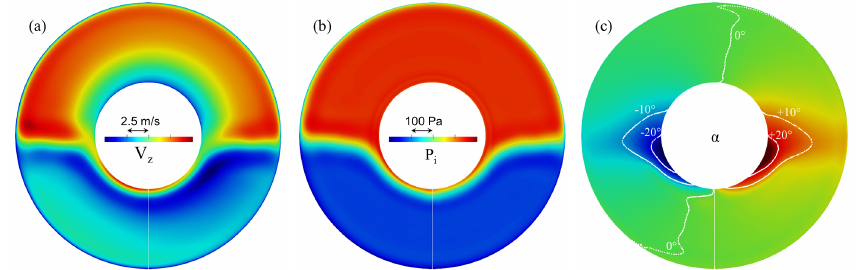
Figure 9. ( a – c ) Boundary conditions used in PC model at free windmill ( T i is uniform).